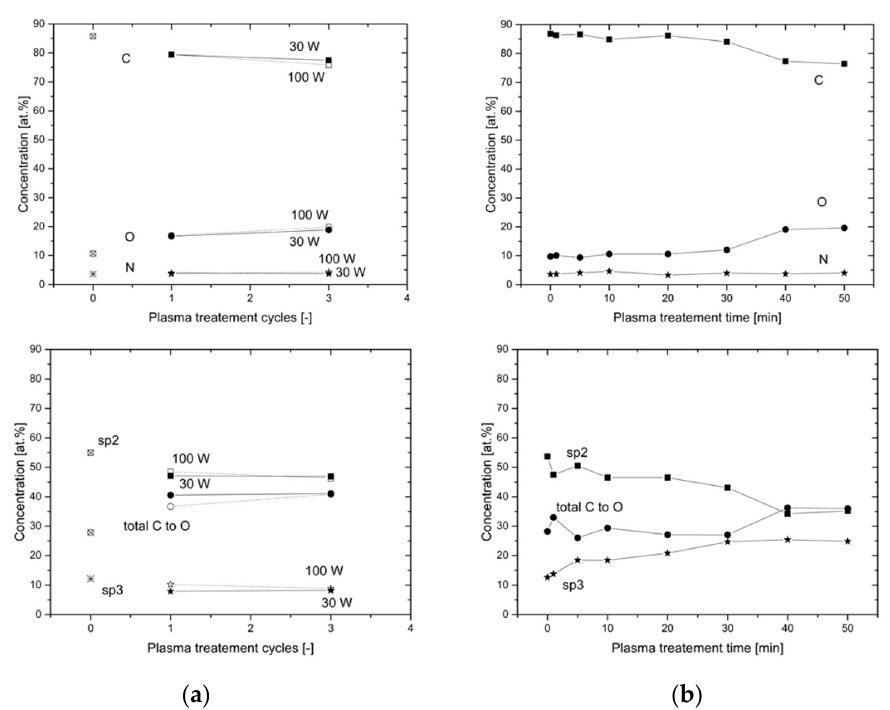
Figure 9. XPS analysis of plasma-treated RCF: ( a ) RF plasma-treated (dotted line = fibers treated at 30 W, solid line = fibers treated at 100 W); and ( b ) MW plasma-treated.